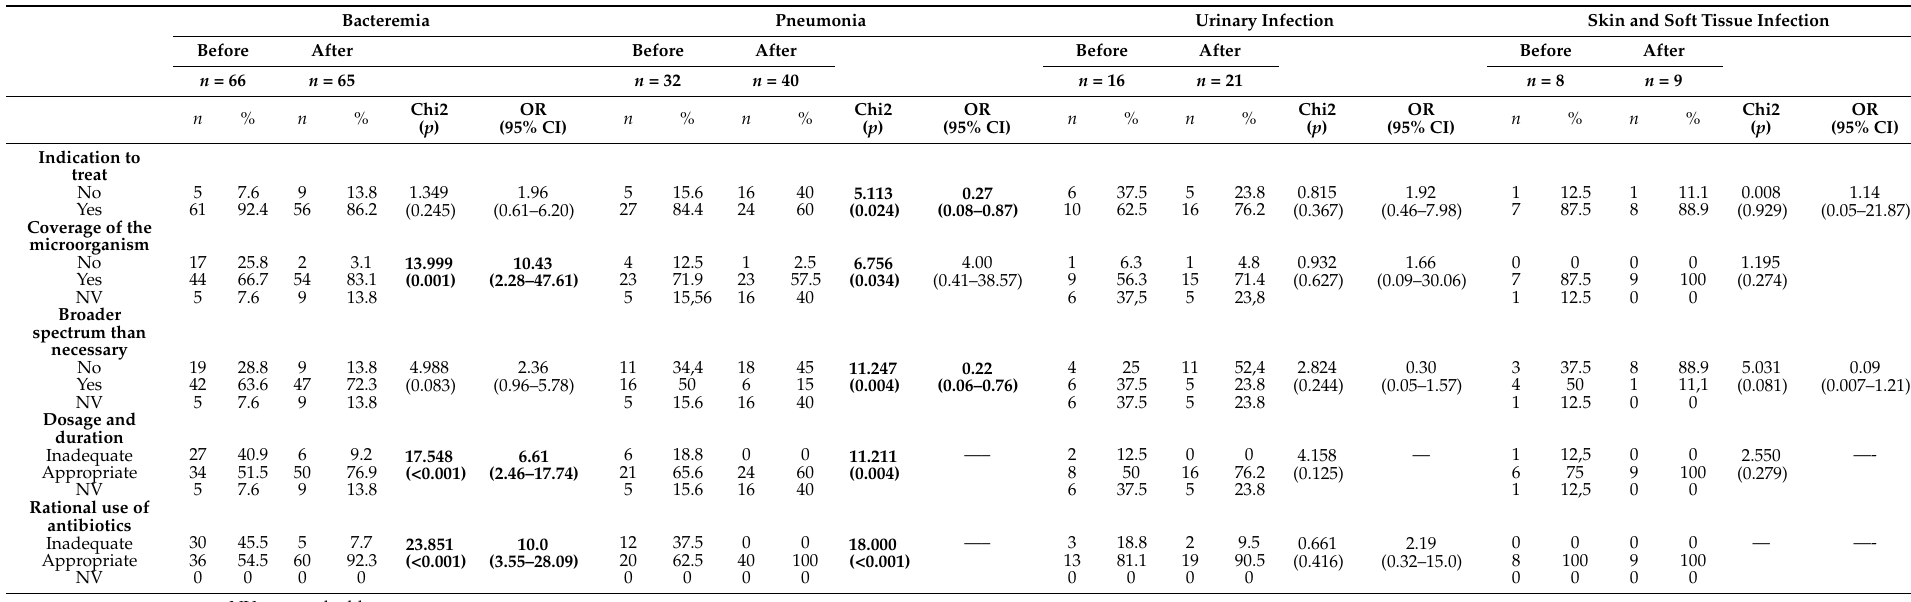
Table 2. Comparison of prescription practice observed in empirical treatments in 122 patients before and 135 patients after training. Bacteremia Pneumonia Urinary